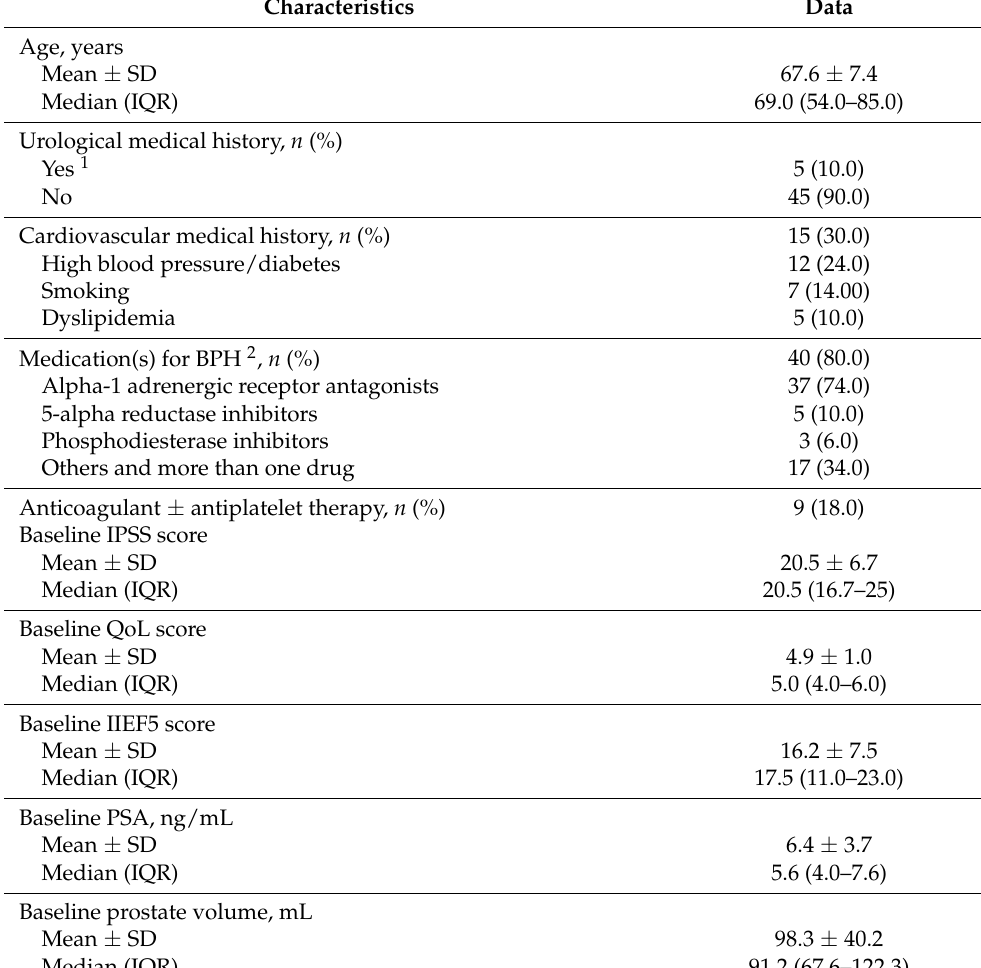
Table 1. Demographics and baseline characteristics of the study